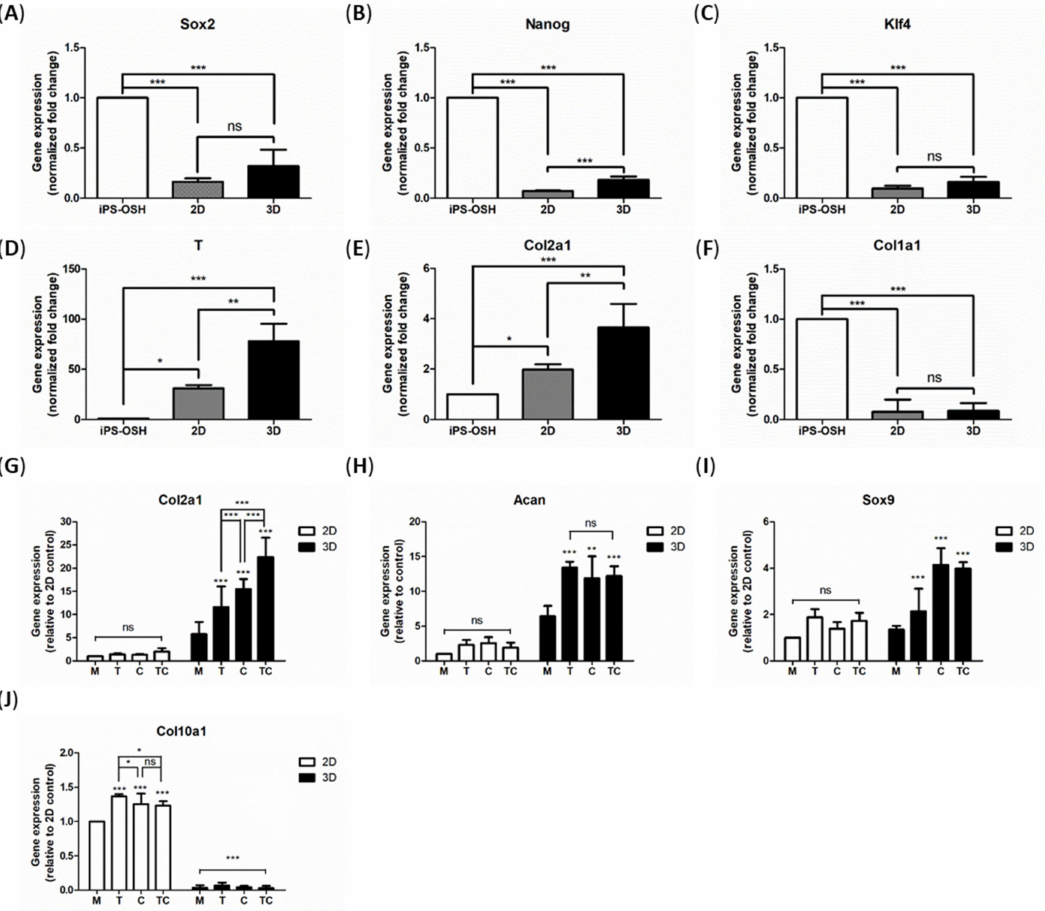
Figure 4. Gene expression profiles. The RNA samples of chondrogenic cultures at the end of each stages were extracted by Trizol reagent according to the manufacturer protocol. The RNA samples collected at the end of stage 1 were used to examine the expression of stem cell markers: Sox2 ( A ), Nanog ( B ) and Klf4 ( C ); mesodermal marker T-box transcription factor T (abbreviation: T) ( D ); chondrogenic marker: Col2a1 ( E ), and osteogenic differentiation marker: Col1a1 ( F ) in different groups. The RNA samples collected at the end of stage 2 were used to examine the expression of Col2a1 ( G ), Aggrecan (Acan) ( H ), Sox9 ( I ), and Col10a1 ( J ) among 2D and 3D cultures of chondrogenic cells, with and without growth factors. Data are shown as the relative fold-change compared to parental iPS-OSH cells or 2D control group, from at least three independent experiments. The expression of Gapdh was detected as the reference gene. Bars represent mean and SD. Difference between groups was evaluated by one-way analysis of variance with Newman–Keuls Multiple Comparison Test (* p = 0.01–0.05; ** p = 0.001–0.01, *** p < 0.001, ns: no statistically significant